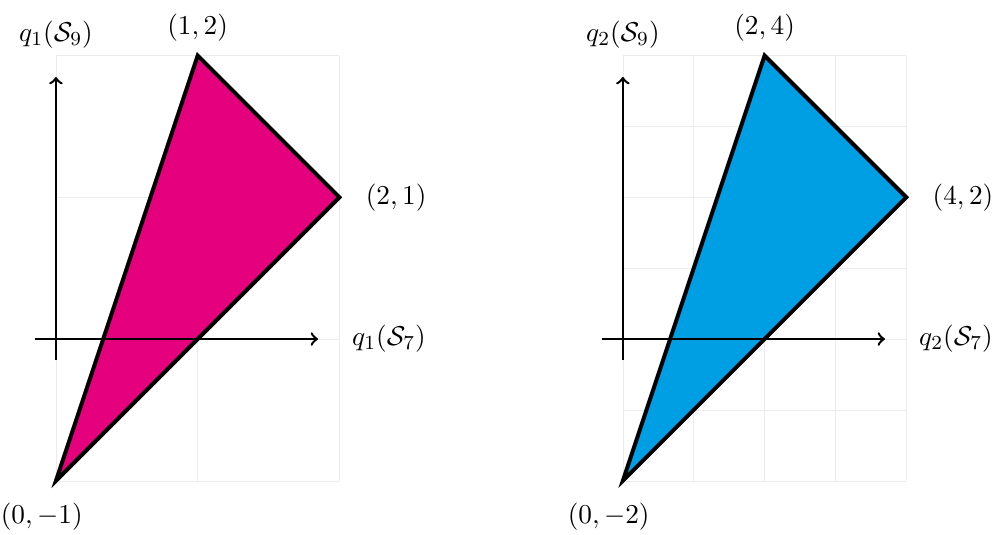
Figure 6 . The admissible choices for ( q i ( S 7 ) ; q i ( S 9 )) ; i = 1 ; 2 correspond to polytopes that are related via a lattice automorphism and scaling to F 4